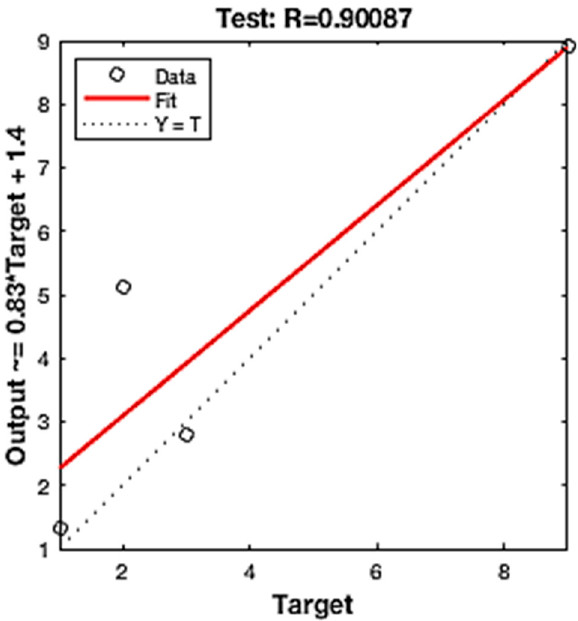
Figure 9. Regression outcomes in the testing phase of the proposed MLANN.